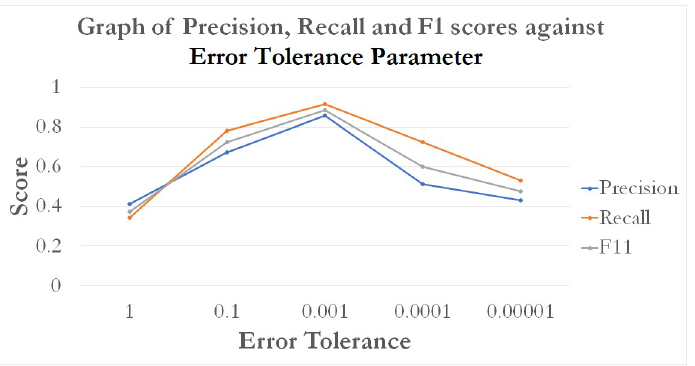
Fig 14. A graph of model performance scores (precision, recall and F1) based on varying MLP prediction error tolerances.